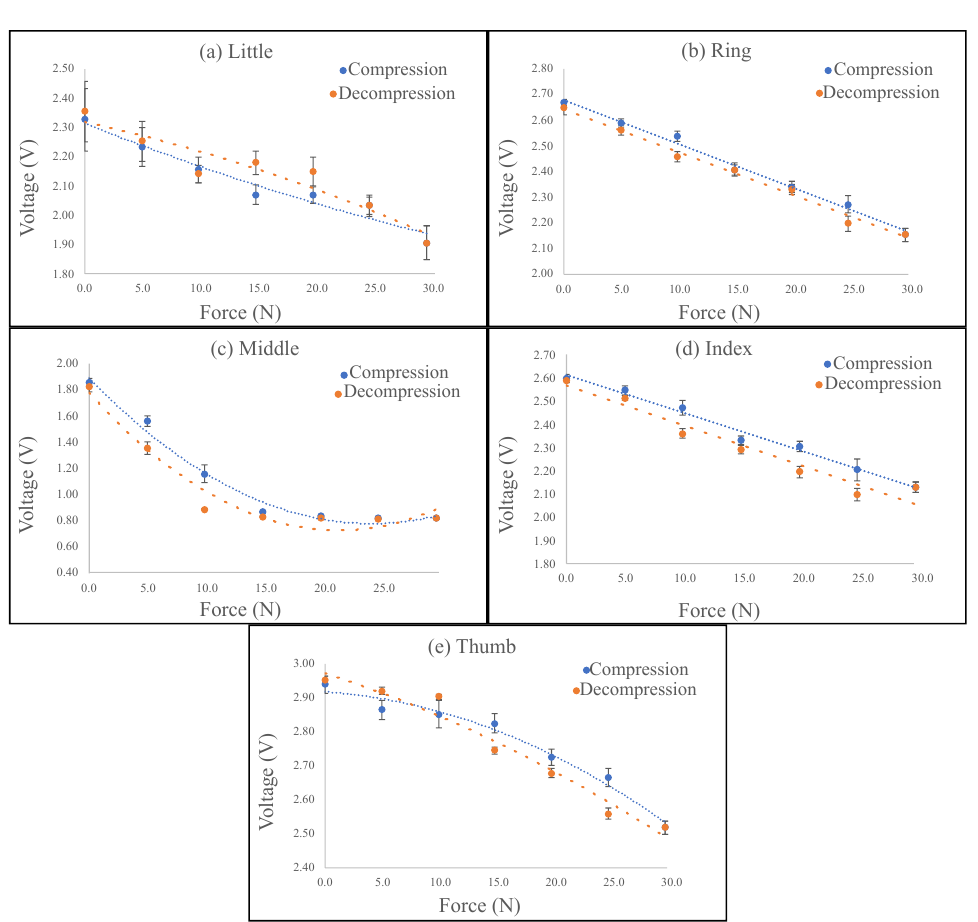
Figure 11. Contact force sensor characterization per finger: the dotted blue line represents compres- sion, and the dashed orange line reflects decompression. ( a ) Little. ( b ) Ring. ( c ) Middle. ( d ) Index. ( e ) Thumb. Table 3. Contact force voltage equations per